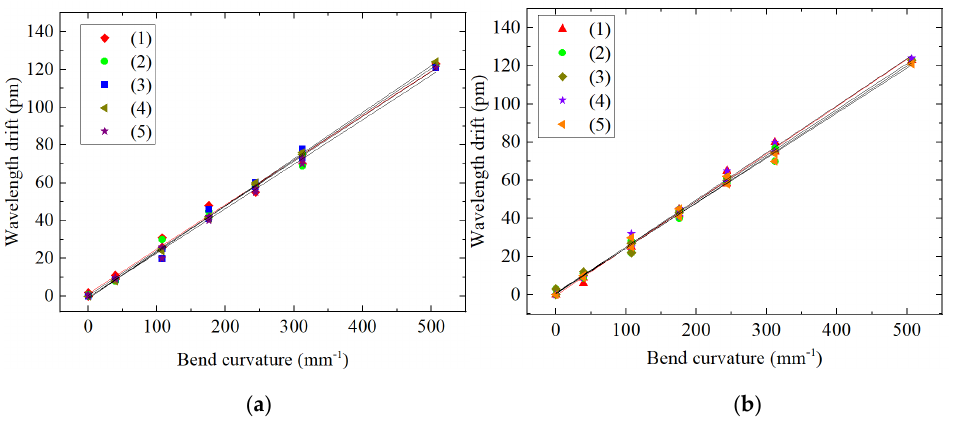
( b ) Figure 16. Shape sensor FBG error analysis of repeatability: ( a ) FBG1 center wavelength drift con- sistency, ( b ) FBG2 center wavelength drift consistency. If the sensor has multiple output characteristic curves under the same input condi- tions many times, the sensor has better repeatability and smaller error, which indicates that the FBG center wavelength drift in the dual FBG high-precision shape sensor is more stable. 4.5. Hysteresis Error Analysis Hysteresis error is one of the important indicators to reflect the accuracy of the sensor. The hysteresis of the sensor is easily caused by the physical properties of the sensor’s sensitive component materials or design defects.